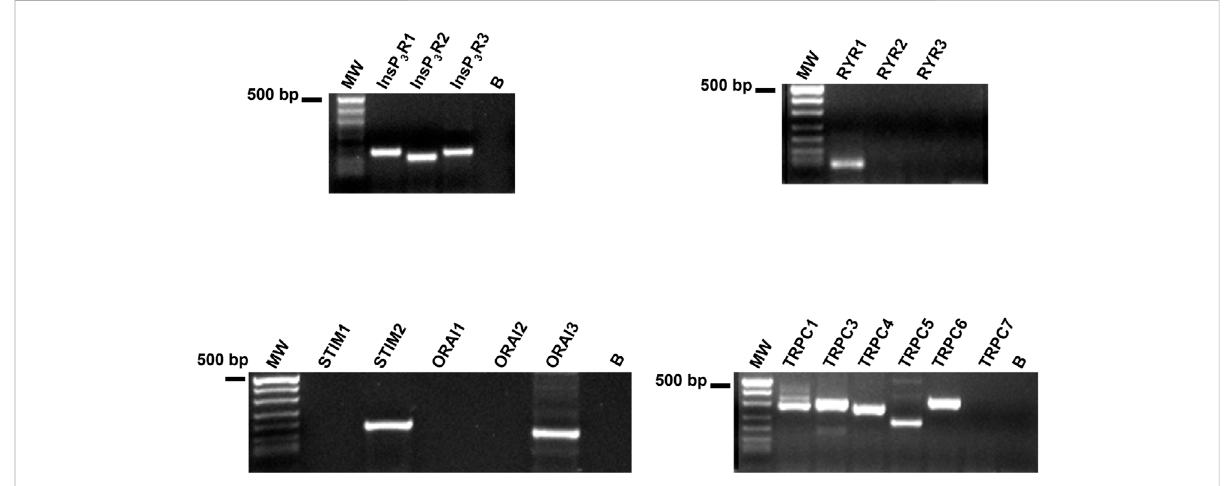
FIGURE 10 Transcriptomic characterization of the Ca 2+ handling machinery in WI-38 fi broblasts. Gel electrophoresis of the PCR products are shown. ElectrophoresiswasperformedasindicatedinMaterialsandMethods.ThePCRproductswereoftheexpectedsize:InsP 3 R1,180 bp;InsP 3 R 2 ,158 bp; InsP 3 R 3 , 173 bp; RyR 1 , 75 bp; TRPC1, 307 bp; TRPC3, 336 bp; TRPC4, 300 bp; TRPC5, 221 bp; TRPC6, 341 bp; STIM2, 186 bp; and Orai3, 159 bp. No signal was observed for STIM1 and Orai1. MW, molecular weight markers. B, reaction without the